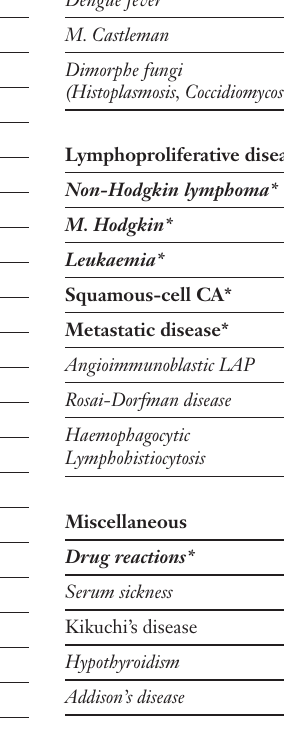
Causes of peripheral lymphadenopathy in